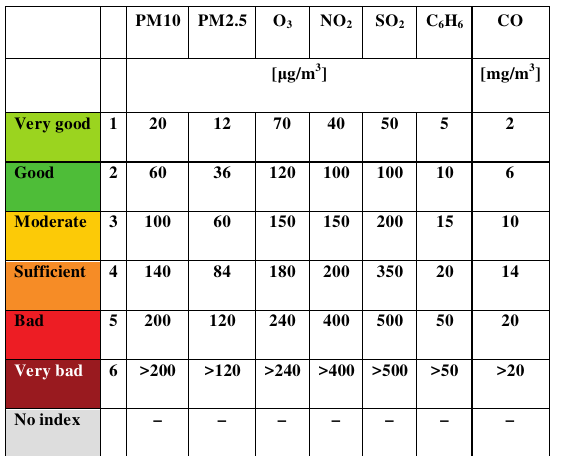
Tab. 1. Limit values of pollution immission for the Polish Air Quality Index for specific substances –